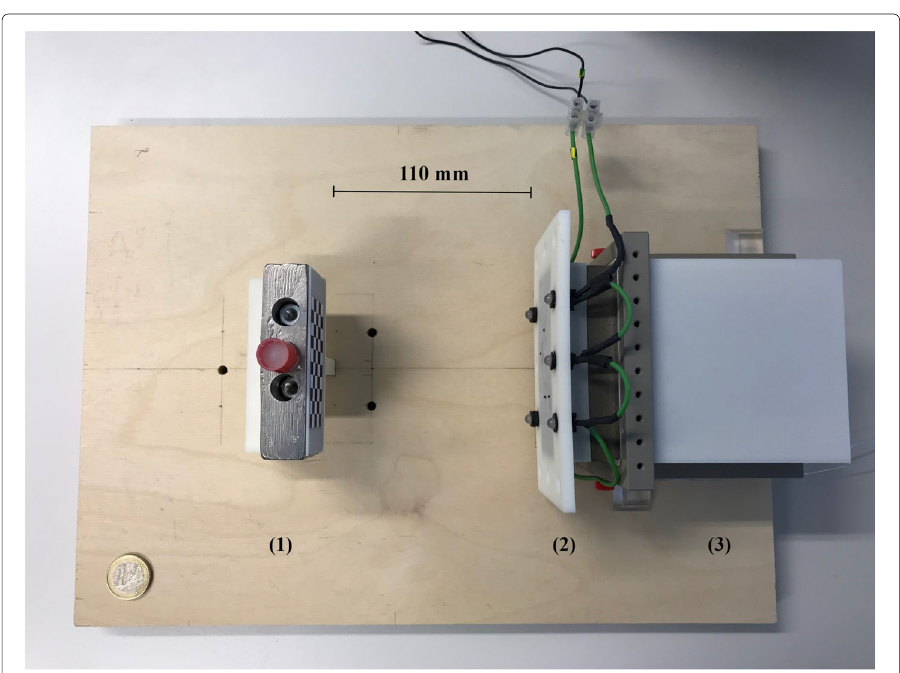
Fig. 4 Calibration setup, viewed from the top. The stand with the calibration target and the vial (red cap) containing the tracer are placed on the left (1). The collimator with the attached camera fixation frame for the microscopic cameras and the LEDs (lighting) are to the right (2). The detector element is adjacent (3). The distance for this measurement is 110 mm from the collimator front plate to the target ( calibrationdefault ). Not shown is the data processing unit of the detector. A 1-euro coin in the lower left serves as a scale reference